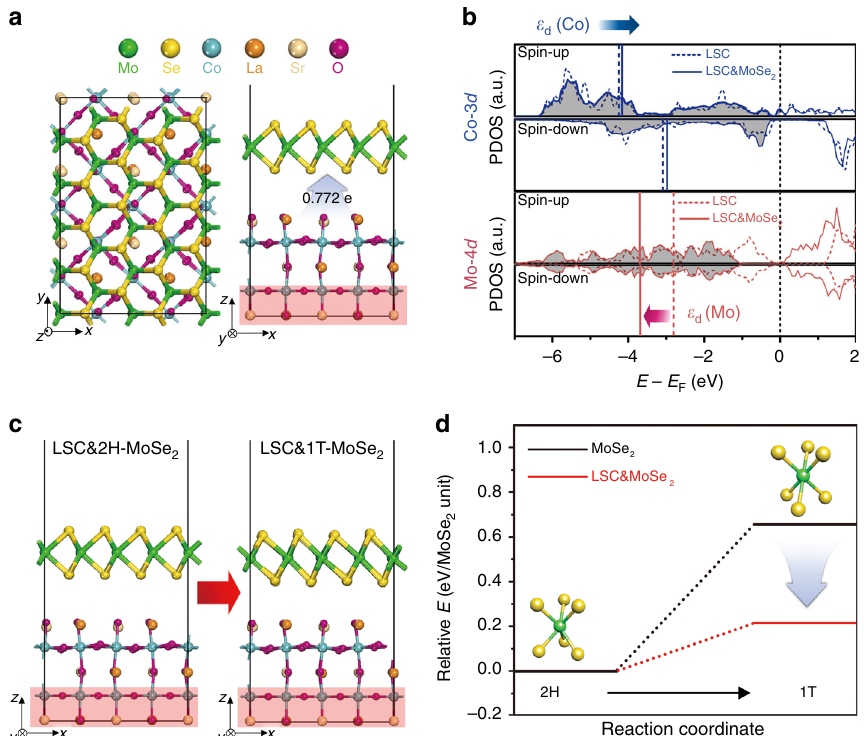
Fig. 5 DFT calculations for charge transfer phenomenon in LSC&MoSe 2 . a Optimized structure of LSC&2H-MoSe 2 heterostructure. The red shaded box represents the fi xed atoms in the two bottommost layers. The blue arrow indicates the direction of charge transfer from LSC to MoSe 2 . b Spin-up and spin- down projected density of states (PDOS) on the following species: Co-3 d in LSC (blue dotted line), Co-3 d in LSC&2H-MoSe 2 (blue solid line), Mo-4 d in 2H- MoSe 2 (red dotted line), and Mo-4 d in LSC&2H-MoSe 2 (red solid line), respectively. The vertical lines represent the position of d-band center ( ε d ) for each species. c Schematic illustration of phase transition from LSC&2H-MoSe 2 to LSC&1T-MoSe 2 heterostructure. d Relative energies of 2H- and 1T-phase of MoSe 2 monolayer (black line) and LSC&MoSe 2 heterostructure (red line). The inset models represent the trigonal prismatic (2H) and octahedral (1T)